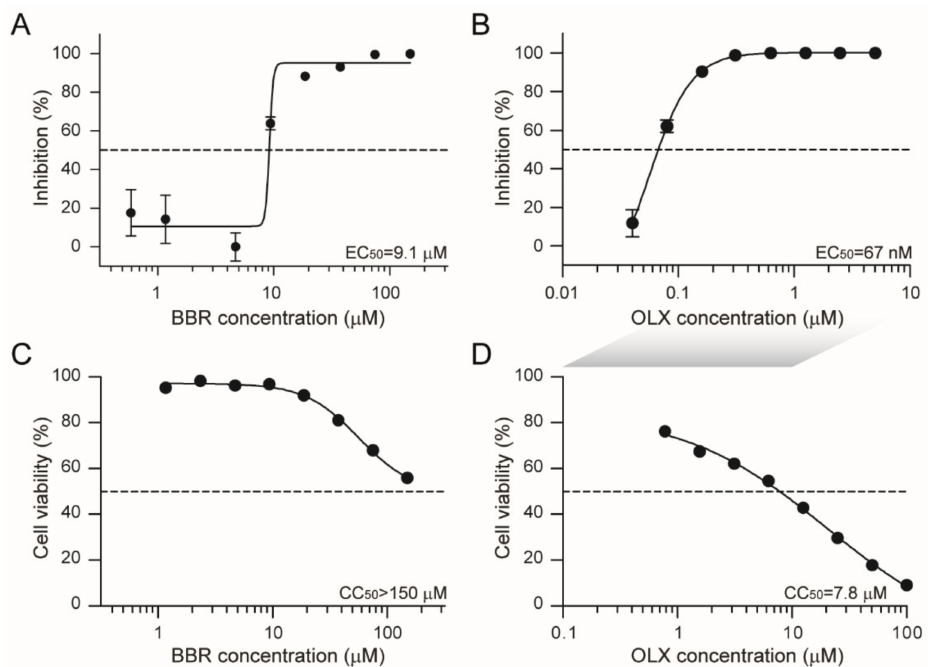
Figure 1. Berberine and obatoclax are effective antiviral compounds against Severe acute respiratory syndrome coronavirus 2 (SARS-CoV-2). Vero E6 cells were infected with SARS-CoV-2 (BavPat1 isolate) at an MOI of 0.01 for 24 h in the presence of the indicated concentrations of ( A ) berberine (BBR) or ( B ) obatoclax (OLX) in a two-fold dilution series or 0.1% DMSO as a control. Infectious viral titers from duplicate cell culture supernatants were assessed by plaque assay and plotted as percentage inhibition compared to the DMSO control. Error bars indicate SD. Dashed lines indicate 50% inhibition. A representative of two independent experiments is shown. Vero E6 cells were treated with the indicated concentrations of ( C ) berberine or ( D ) obatoclax or 0.1% DMSO. 24 h post-treatment, ATP content in cells from triplicate wells was measured as indication for cell viability, plotted as percentage compared to the DMSO control. Error bars indicate SD. A representative of two independent experiments is shown. The shaded grey box indicates that different OLX concentrations were used for antiviral (B) and viability assays